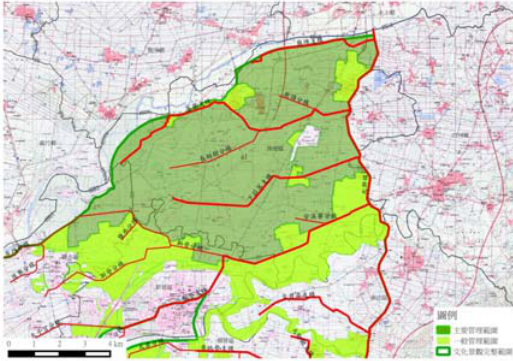
Figure 7. Part of the Jiannan Irrigation System’s